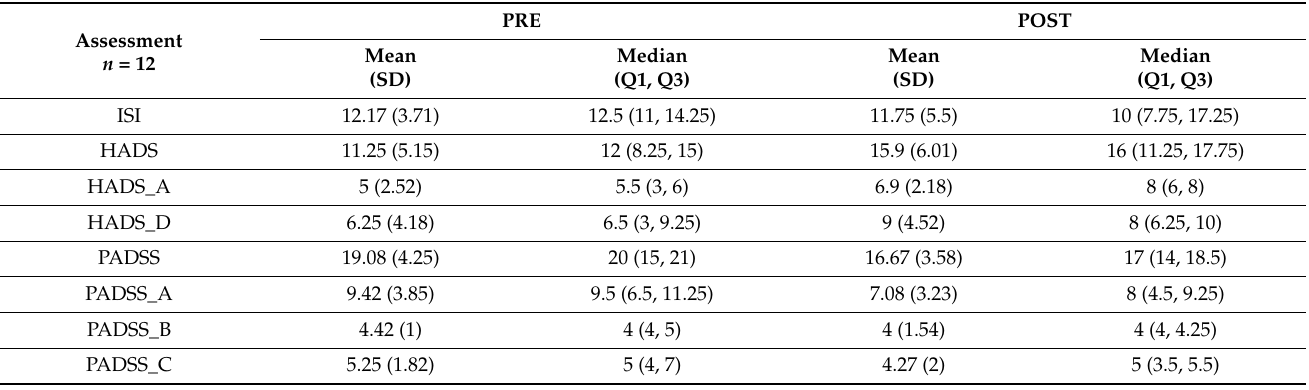
Table 1. Outcomes of ISI, HADS and PADSS assessment after CBT-NREMP intervention (PRE) and subsequent postal survey findings (POST).